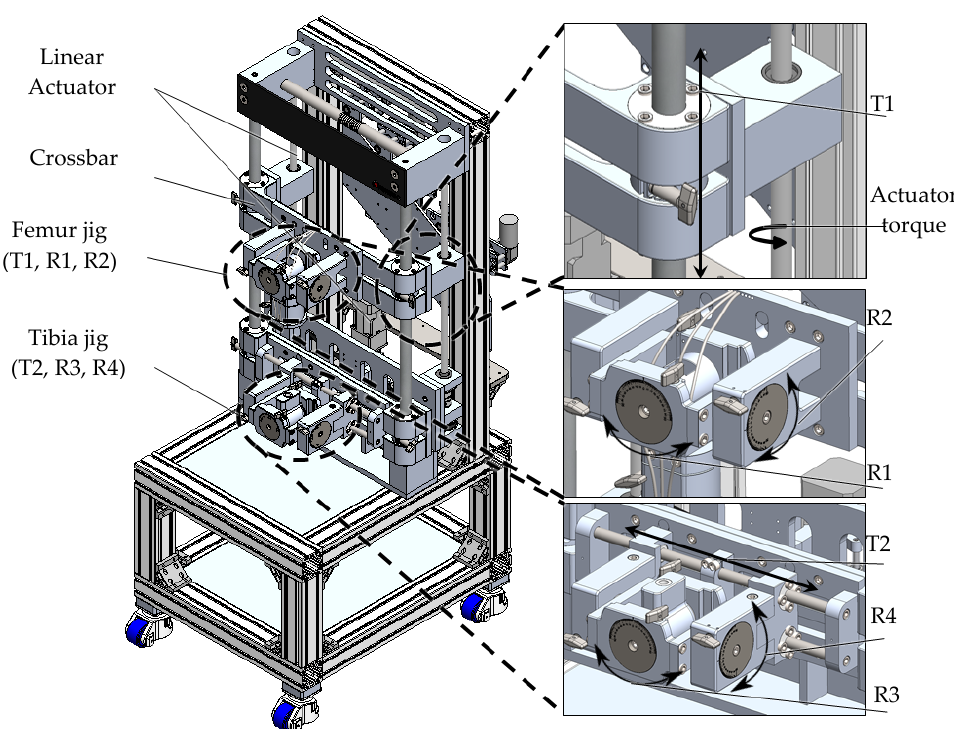
Figure 1. Schematic overview of simulator components and their degrees of freedom (T1: proximal–distal displacement on the femur; R1: varus–valgus rotation on the femur; R2: flexion–extension rotation on the femur; T2: medial–lateral displacement on the tibia; R3: varus–valgus rotation on the tibia; R4: flexion–extension rotation on the tibia) in the knee-simulator